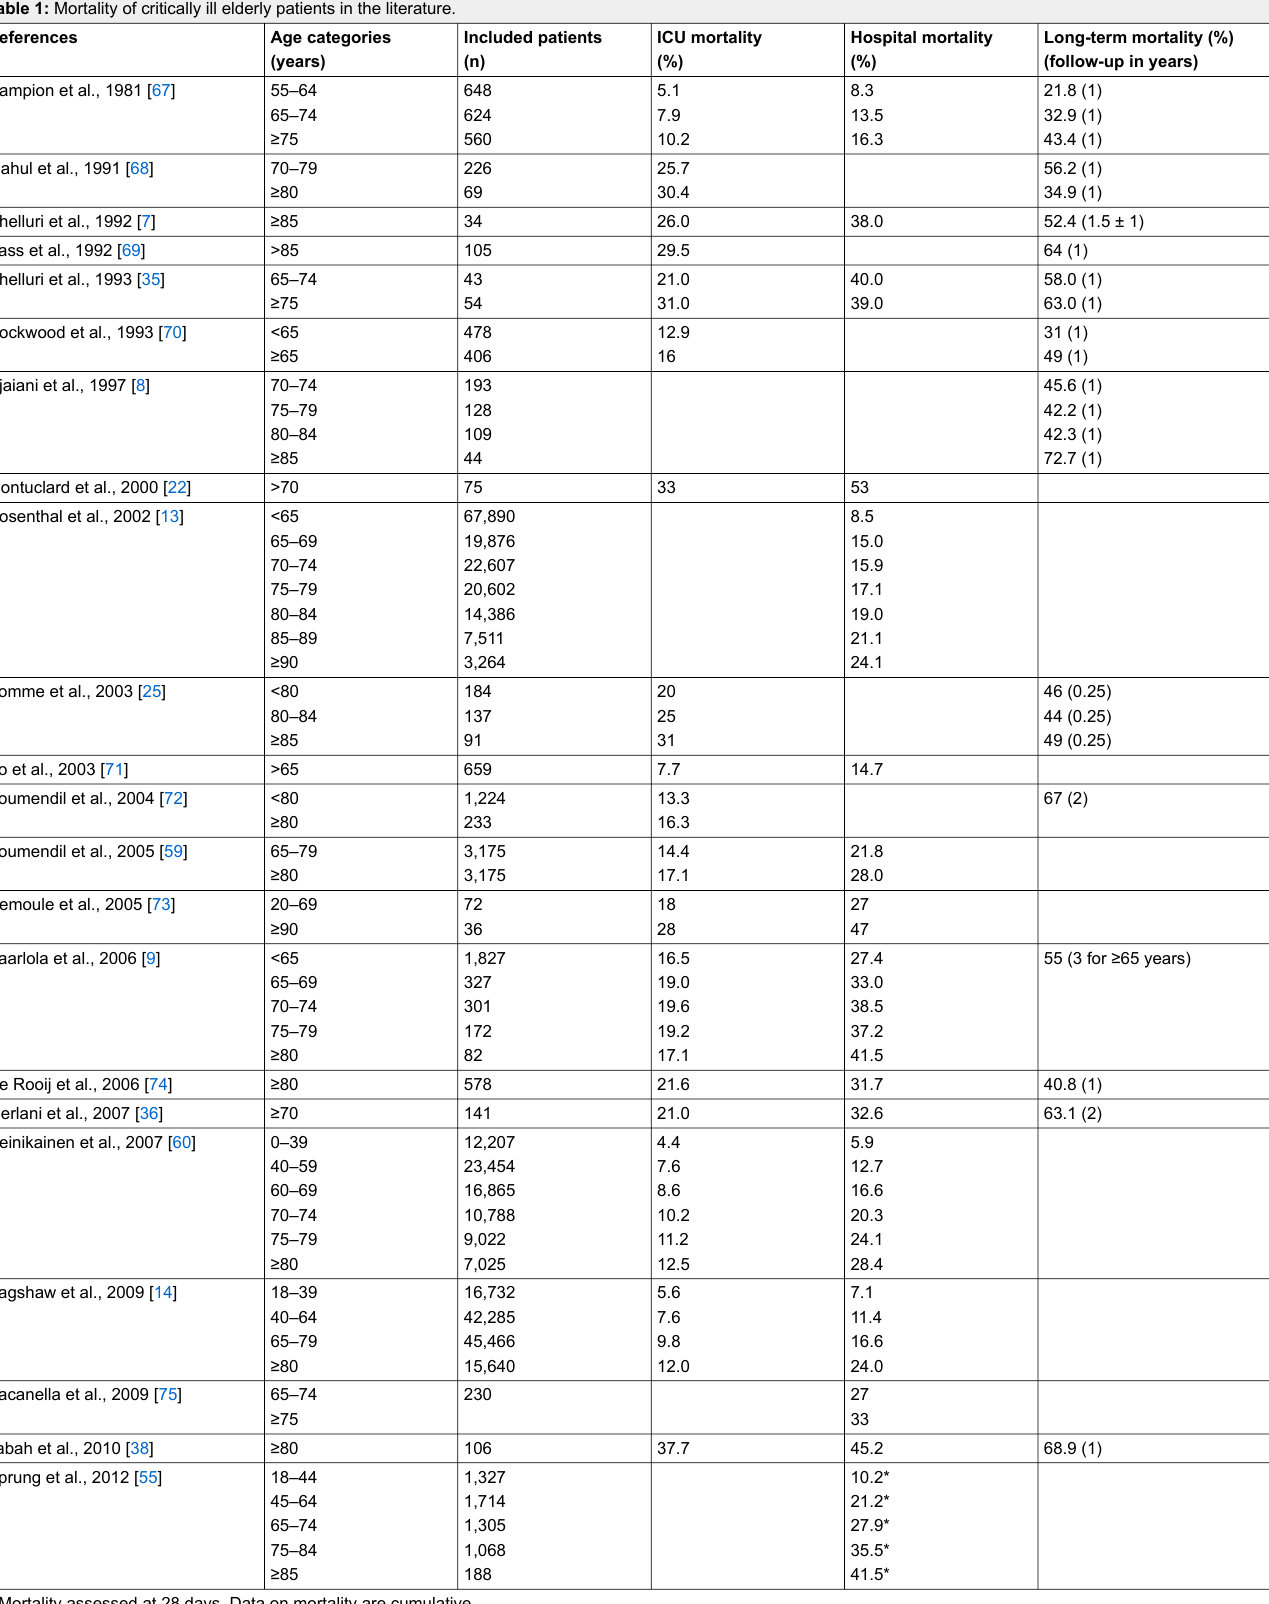
Table 1: Mortality of critically ill elderly patients in the